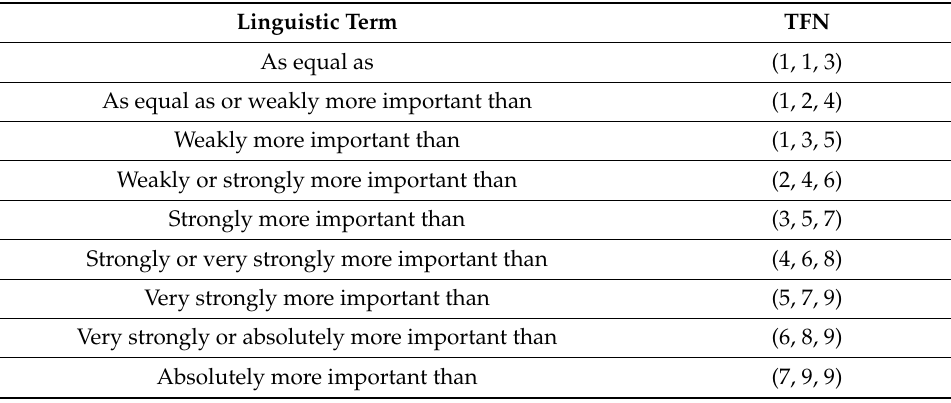
Table 2. TFNs for expressing linguistic terms.*